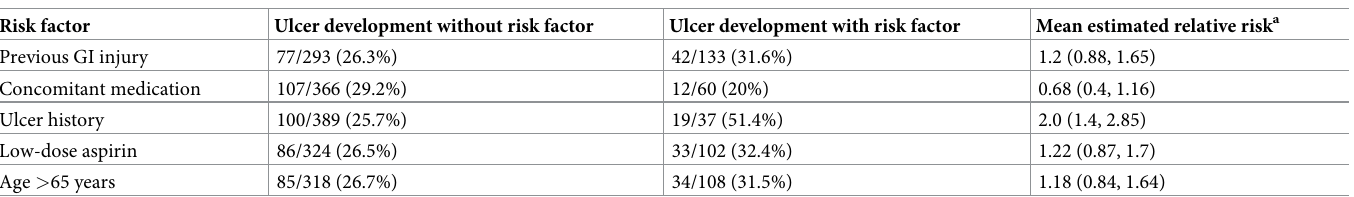
Table 3. Ulcer development under naproxen treatment (n = 426).